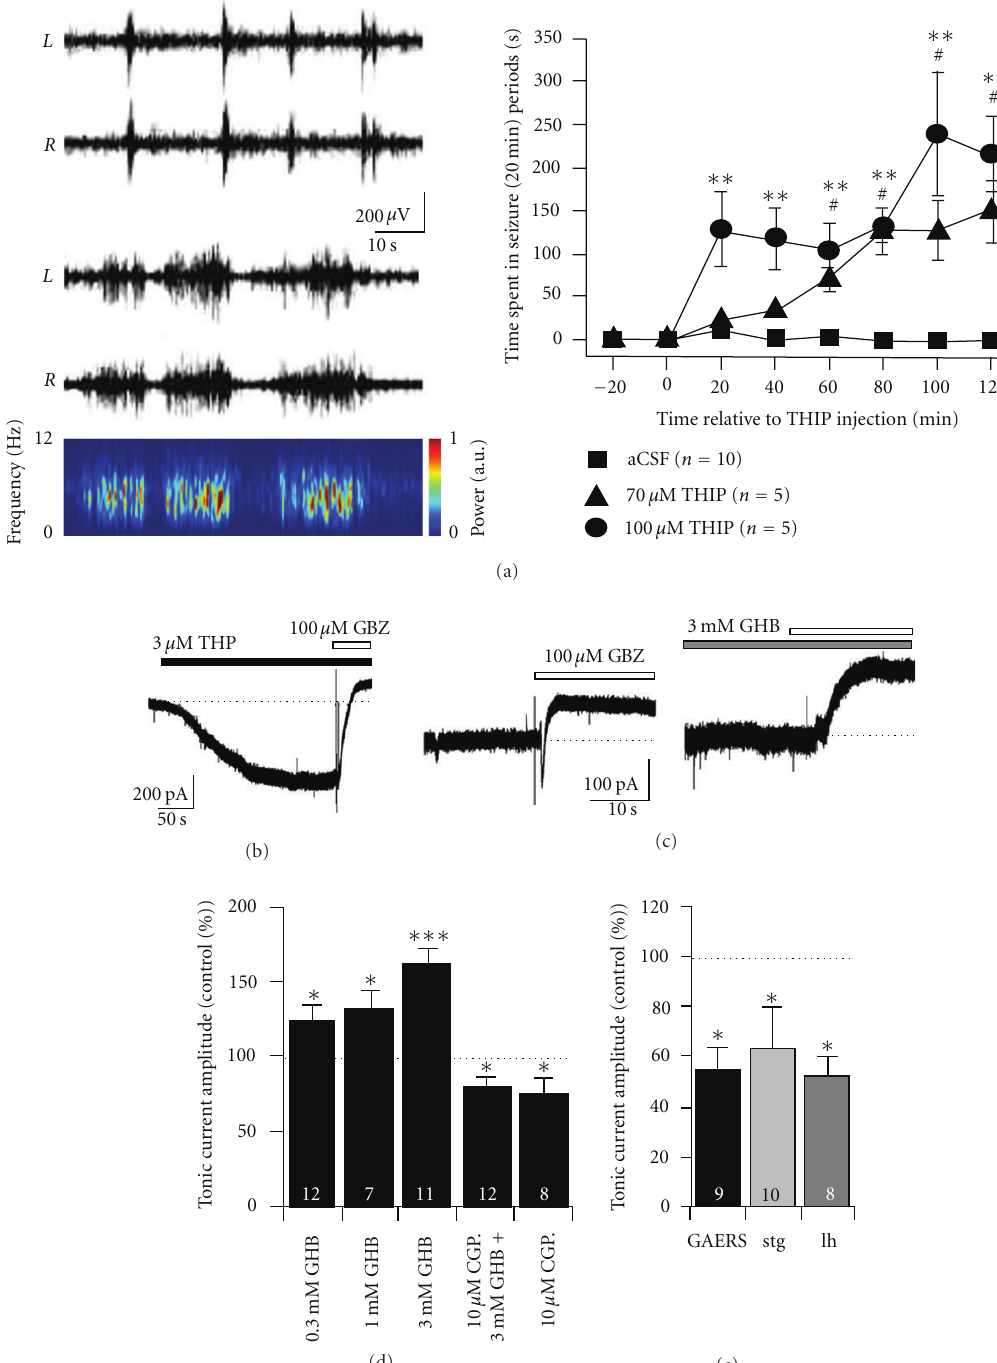
Figure 2: GHB and THIP enhance tonic GABA A currents in VB thalamus in vitro and induce SWDs in vivo . (a) Examples of SWDs in bilateral EEG traces recorded from Wistar rats following selective activation of eGABA A Rs by intrathalamic application of THIP via microdialysis (100 μ M). The top trace shows seizures occurring in the first hour after THIP administration and the bottom the second hour. The spectrogram (corresponding to the right hemisphere of the lower traces) clearly shows an increase in oscillatory power in the 5–7 Hz range typical of SWDs in rats. The graph (right) summarises the concentration-dependent emergence of SWDs after THIP application as the total time spent in seizure during 20 minutes bins. (b) THIP produces robust enhancement of tonic GABA A currents in VB TC-neurons in acute brain slices in vitro . (c) GHB produces increased tonic current in VB TC neurons. (d) Graph summarising the concentration-dependent enhancement of thalamic tonic currents by GHB and the blocking e ff ect of the GABA B R antagonist CGP55845. (e) Block of GABA B Rs by CGP55845 produces a reduction of tonic GABA A currents in VB TC neurons of epileptic GAERS, stargazer, and lethargic mice. ∗ P < 0 . 05, ∗∗ P < 0 . 01, ∗∗∗ P < 0 . 001. Number of recorded neurons for each condition is indicated inset into bars. (a–e) reproduced from reference